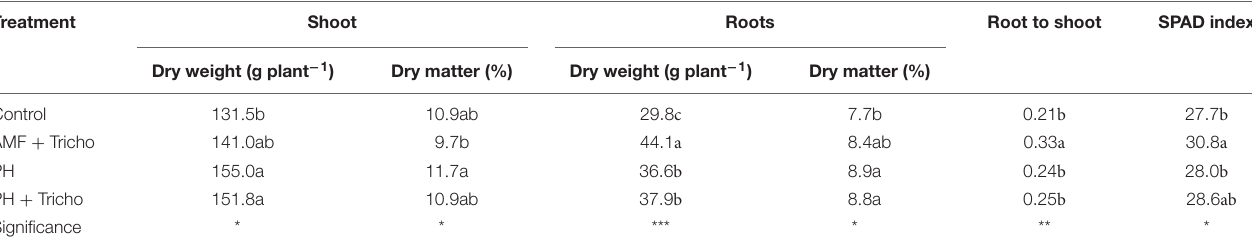
TABLE 1 | Effect of seed treatments with a consortium of arbuscular mycorrhizal fungi (AMF), Trichoderma koningii TK7, and rhizosphere bacteria or with a consortium of Trichoderma koningii TK7 and rhizosphere bacteria (Tricho) plus a protein hydrolyzate-based biostimulant (PH), or with a protein hydrolyzate-based biostimulant (PH), on dry weight and dry matter of shoots and roots, root-to-shoot ratio and SPAD index in maize plants. Treatment